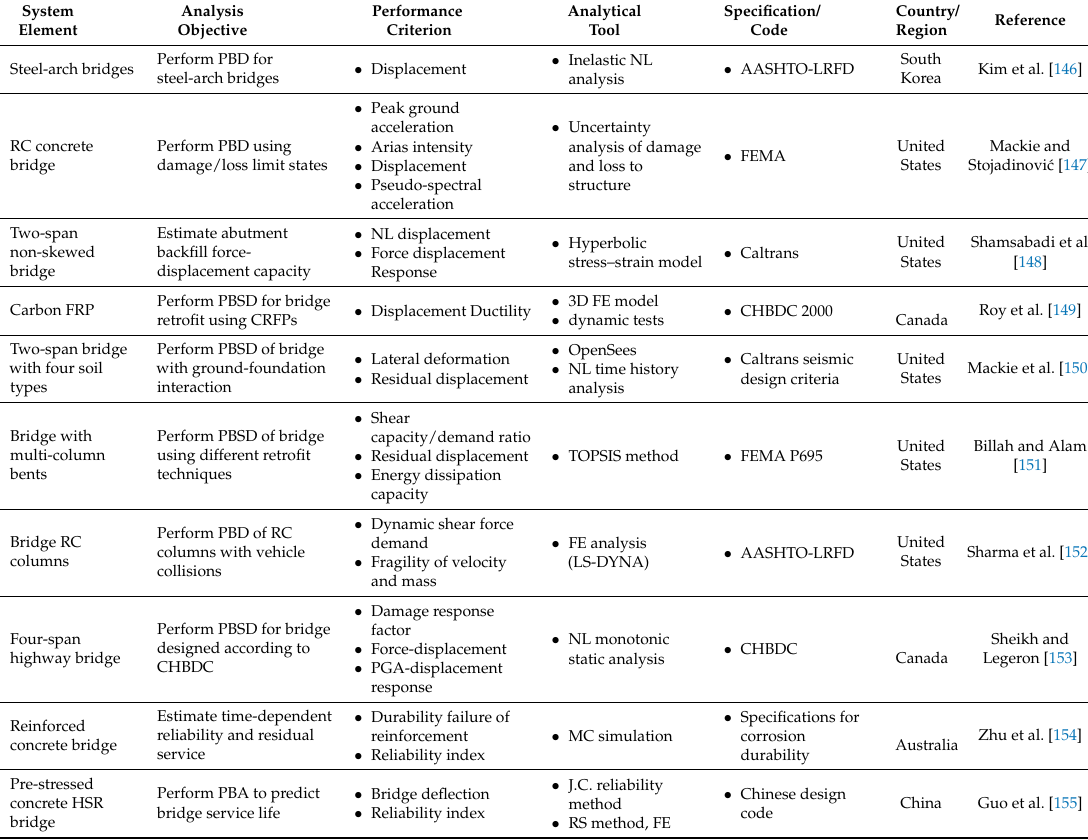
Table A11. Characteristics of bridge design and management